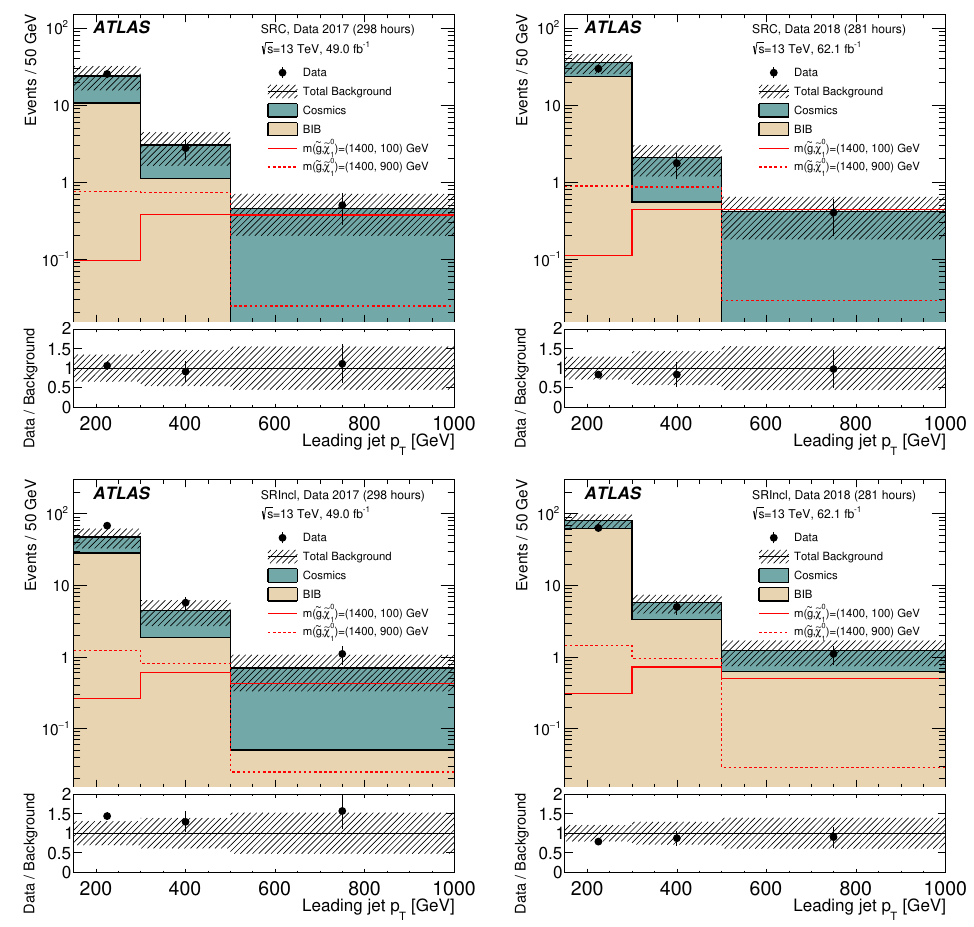
Figure 8 . Observed and expected leading-jet p T distributions, with the bin boundaries considered for the interpretation, in 2017 data (left) and 2018 data (right) in SRC (top) and SRIncl (bottom). All statistical and systematic uncertainties of the expected background are included in the hatched band. The last bin contains the overflow. Two example signal models with a gluino mass of 1 . 4 TeV and neutralino masses of 100 GeV and 900 GeV are overlaid, where the yields are calculated assuming a gluino lifetime within the range of the live-fraction